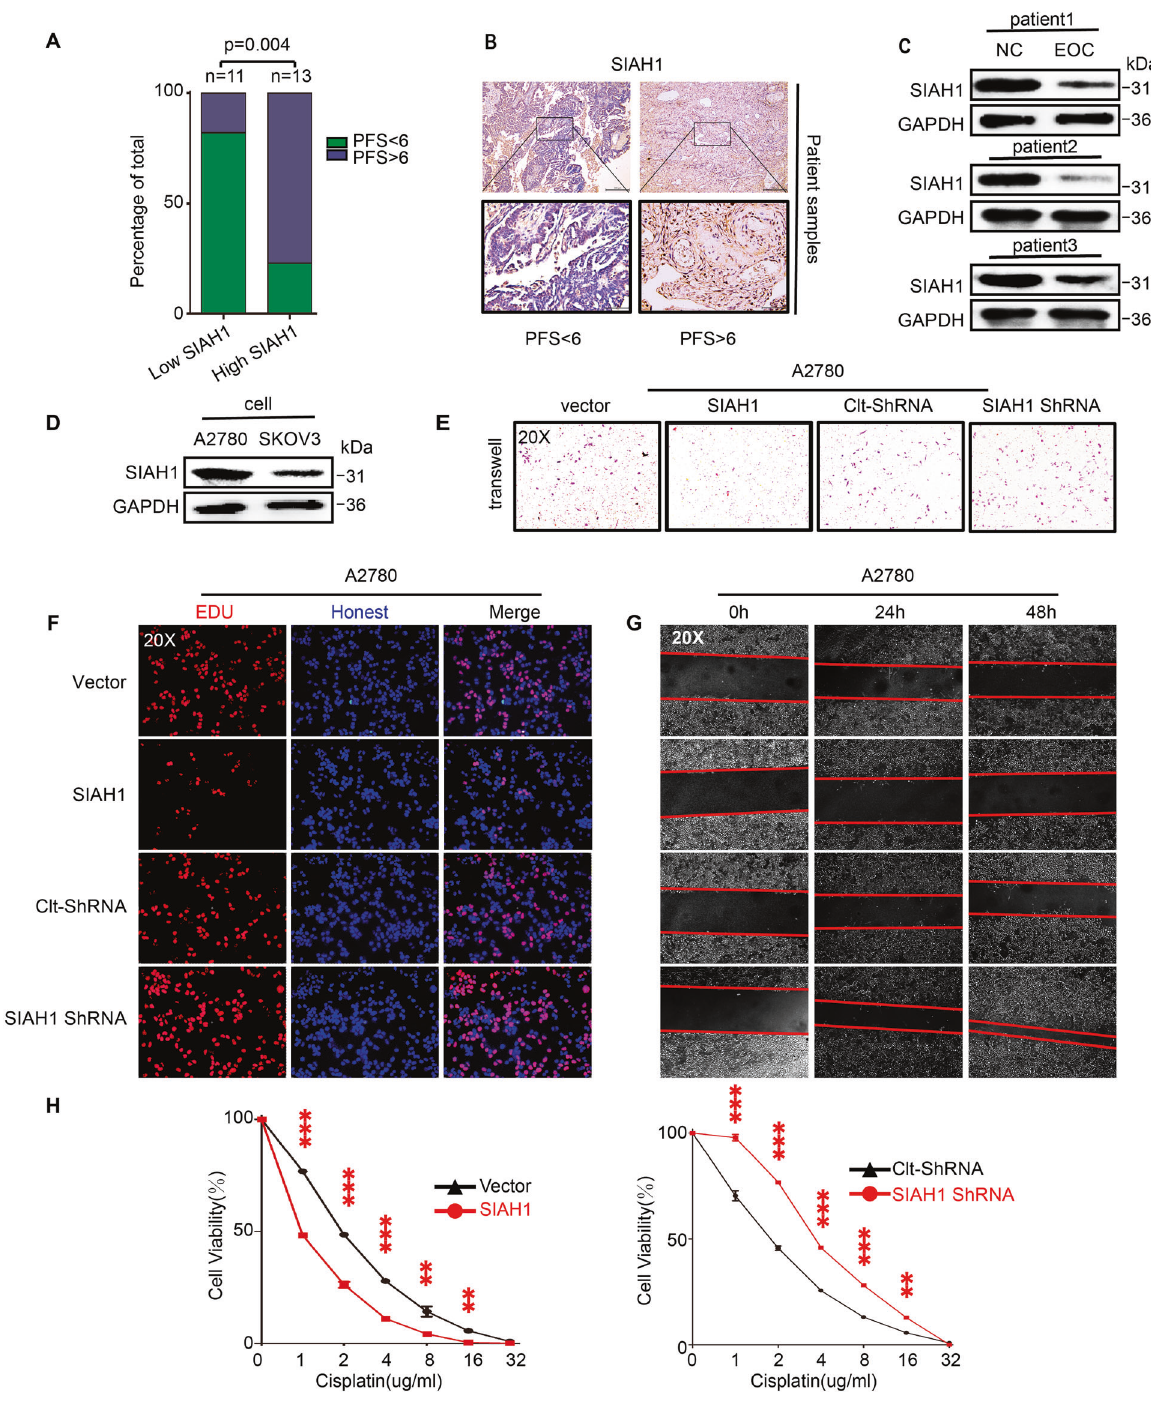
Fig. 2 SIAH1 inhibits the proliferation, invasion, migration, and drug resistance of EOC cells. A A signi fi cant association was found between SIAH1 expression with PFS of EOC (SIAH1 low = SIAH1 staining positive rate <25%, SIAH1 high = SIAH1 staining positive rate > = 25%) in 24 patients. B IHC of SIAH1 expression in EOC tissues of patients who were platinum-sensitive (PFS >6) and -resistant (PFS <6). C SIAH1 was downregulated in the serum of EOC patients (EOC) compared with healthy controls (HC). D The protein level of SIAH1 was downregulated in SKOV3 cells compared with A2780 cells. E Transwell invasion assay, F EdU assay, G wound-healing assay, and H CCK-8 assay was performed to detect the cell invasion, proliferation, migration, and viability of A2780 cells subcutaneous tumors volume and observed that SIAH1 over- measured the tumor volume (Fig. 3A). It was observed that tumors expression decreased the drug resistance of EOC cells in vivo from mice injected with Lv-SIAH1-infected A2780 cells were (Fig. 3C). In addition, the high level of SIAH1 was associated with signi fi cantly smaller than those from mice processed with control the low proliferative capacity of the tumors (Fig. 3D, E, G and cells, while tumors from mice injected with Lv-shSIAH1 were Supplementary Fig. S2A, B). Furthermore, as shown in (Fig. 3F and visibly larger (Fig. 3B). We calculated the diameter of